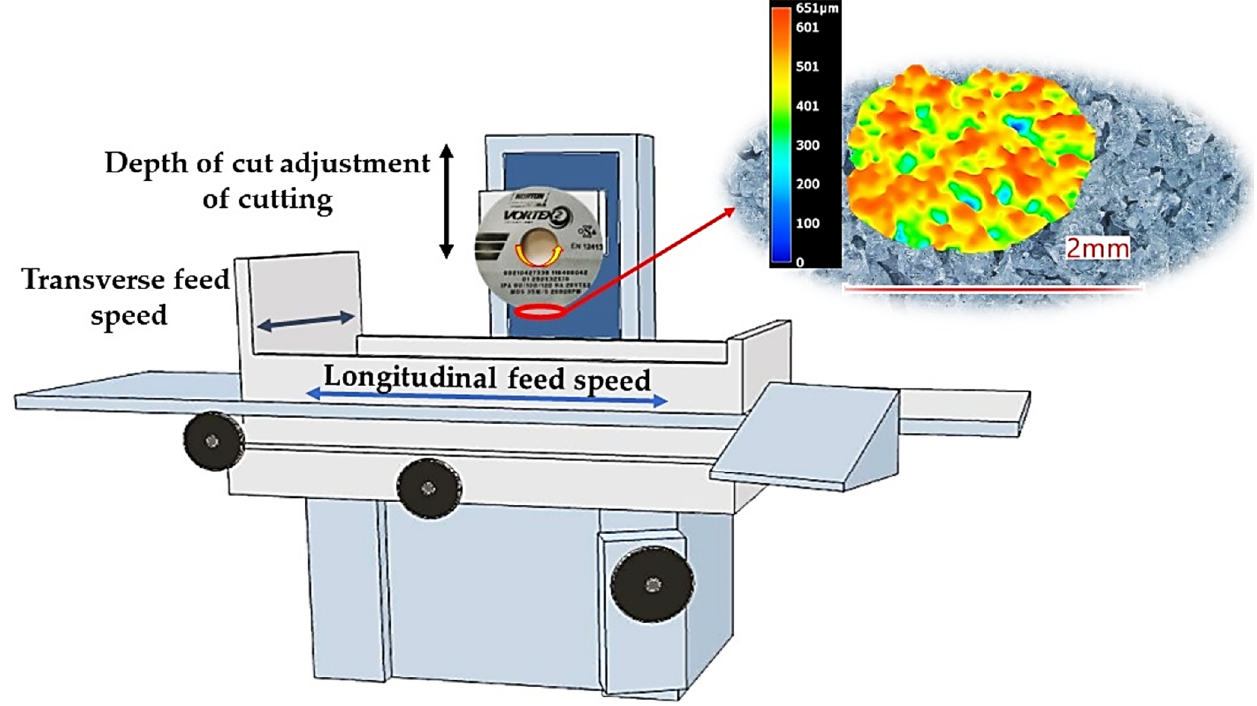
Figure 1. Scheme of the machining station.